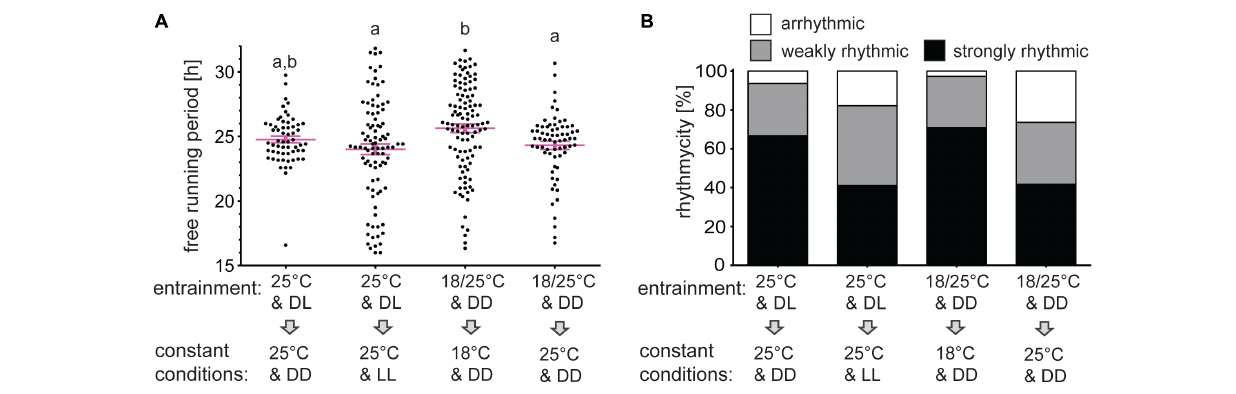
Frontiers in Physiology |